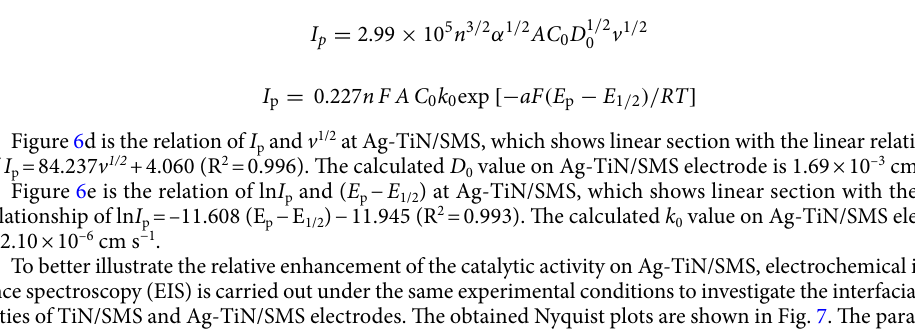
Figure 6d is the relation of I p and v 1/2 at Ag-TiN/SMS, which shows linear section with the linear relationship of I p = 84.237 v 1/2 + 4.060 (R 2 = 0.996). The calculated D 0 value on Ag-TiN/SMS electrode is 1.69 × 10 –3 cm s −1 . Figure 6e is the relation of ln I p and ( E p − E 1/2 ) at Ag-TiN/SMS, which shows linear section with the linear relationship of ln I p = –11.608 (E p − E 1/2 ) − 11.945 (R 2 = 0.993). The calculated k 0 value on Ag-TiN/SMS electrode is 2.10 × 10 –6 cm s −1 . To better illustrate the relative enhancement of the catalytic activity on Ag-TiN/SMS, electrochemical imped- ance spectroscopy (EIS) is carried out under the same experimental conditions to investigate the interfacial prop- erties of TiN/SMS and Ag-TiN/SMS electrodes. The obtained Nyquist plots are shown in Fig. 7. The parameters